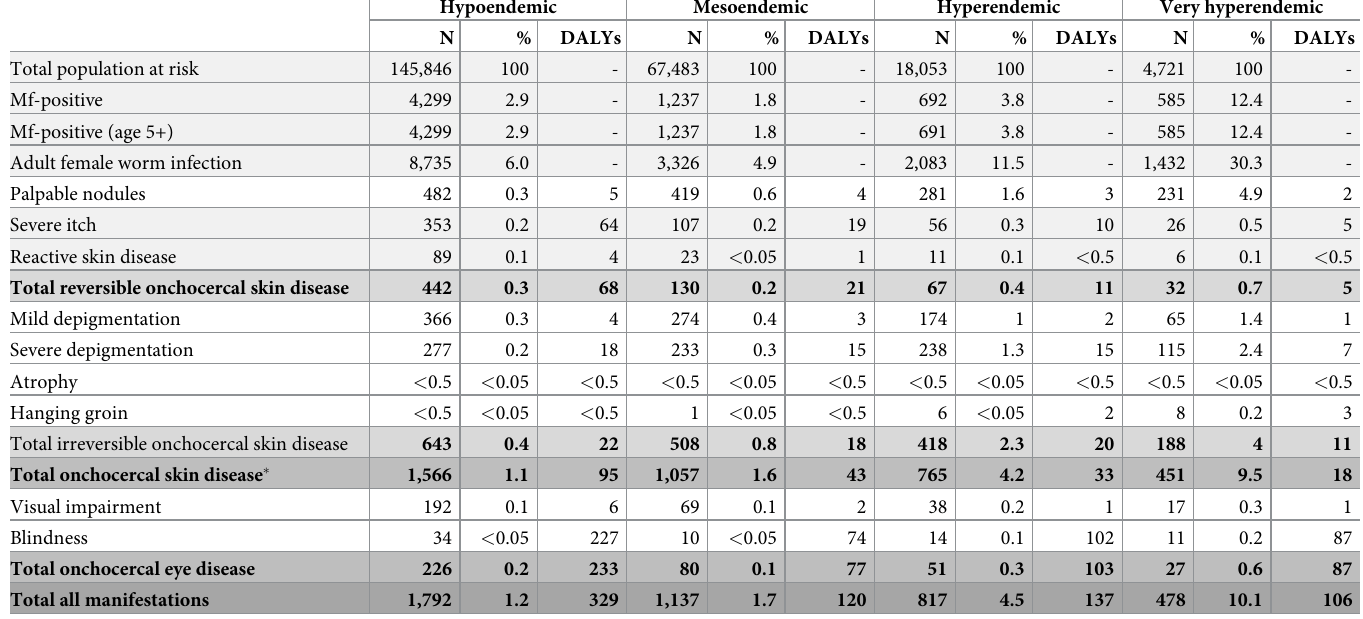
Table 2. Population at risk and numbers of cases infected and with clinical manifestations by endemicity level for 2030. Absolute numbers (N and DALYs) are pre- sented in